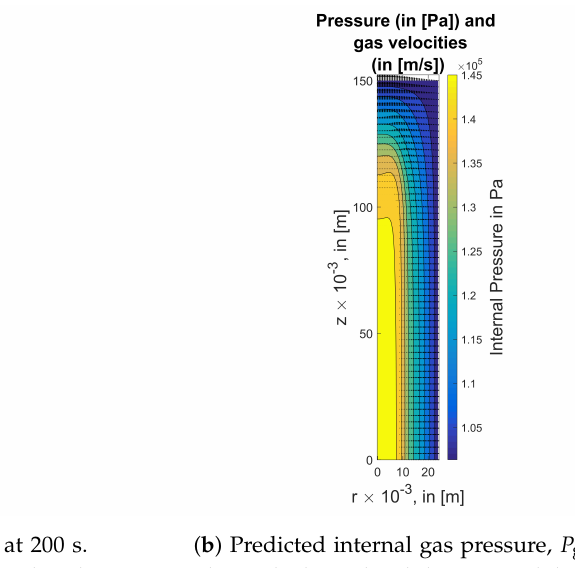
Figure 7. Internal gas pressure and axial and radial gas velocities (small vectors that are most easily seen at the top of the figure). The top of the wood log is at z = 150 mm, and the initial lateral surface of the wood log is at r = 25 mm. The applied wood and char permeabilities are listed in Table 2. (Please note that the range of the color scaling is different in the two